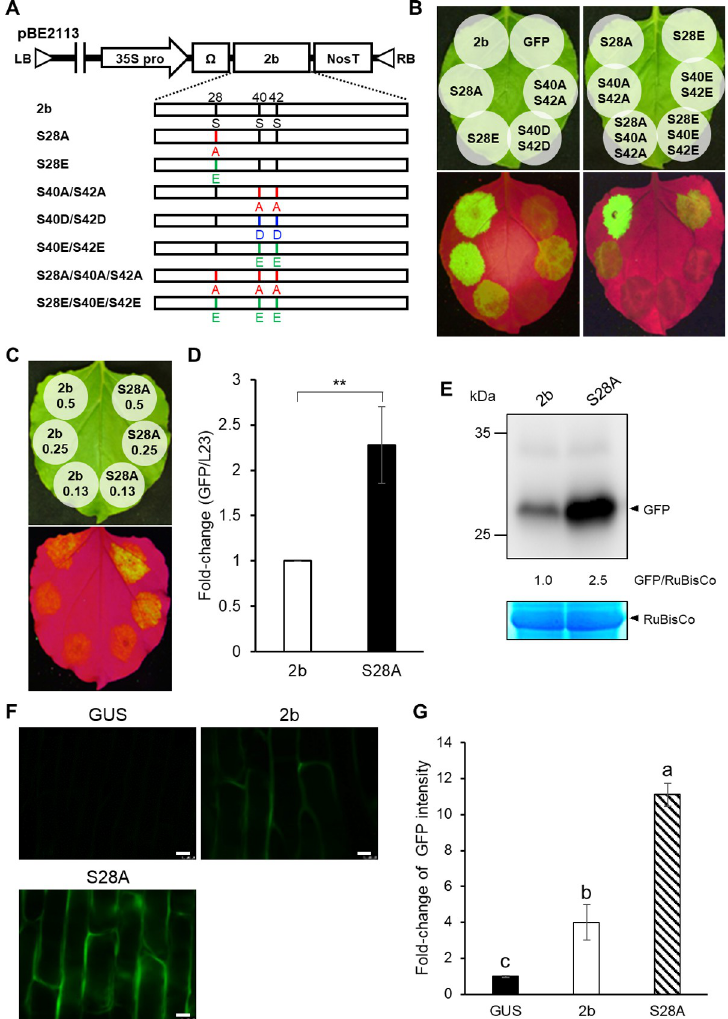
Fig 4. RSS activity of 2bs with mutations at phosphorylation sites. (A) Schematic structure of expression vector constructs containing mutant 2bs. The mutant 2bs were created by substituting S28, S40 and S42 with alanine (A), glutamic acid (E) or aspartic acid (D). (B) RSS activity of the mutant 2bs in the agroinfiltration transient expression assay. Agrobacterium cultures carried a 5:1:5 ratio of the GFP-sense (GFP), GFP-inverted-repeat (GFP-IR), and the 2b constructs. N . benthamiana leaves were agroinfiltrated with bacterial suspensions (~1.0 OD 600 ). GFP was examined at 2 days post-infiltration. Inoculum containing GFP and GFP-IR was used as a control for GFP silencing. (C–E) Comparison of RSS activity between 2b and S28A in N . benthamiana . The Agrobacterium suspension of 2b or S28A was serially diluted to OD 600 = 0.5, 0.25 and 0.13. The inocula were a mixture of Agrobacterium cultures carrying the GFP, GFP-IR and the 2b constructs. (C) Leaves were examined for GFP fluorescence at 2 days post-infiltration. (D) Real-time RT-PCR to compare GFP mRNA levels between 2b and S28A. The agroinfiltrated patches, where GFP, GFP-IR and 2b were simultaneously expressed, were excised. Mean values ( ± SE) are fold-changes when the value in 2b was set to 1.0. The values were analyzed on log-transformed data by Student’s t -test ( �� P < 0.01). (E) GFP in agroinfiltrated patches was detected by western blot analysis using anti-GFP antibodies. RuBisCo large subunit is shown as a loading control. The ratios of GFP/RuBisCo were densitometrically calculated when the value in 2b was set to 1.0. (F and G) Comparison of RSS activity between 2b and S28A in onion epidermal tissues. Onion bulb scales were infiltrated with a mixture of Agrobacterium suspension of GFP, GFP-IR and 2b. The plant experimental vector pBE2113 (GUS) was used as a negative control. GFP florescence was observed with an epifluorescence microscope. GFP fluorescence intensity was measured for three different onion scales using the LAS AF program (Leica). Scale bar: 50 μ m. The values of GFP florescence are fold-changes when the value in GUS was set to 1.0. Means ( ± SE) were tested on log-transformed data for a significant difference using Tukey’s multiple comparison test ( P < 0.05); different letters above the bars indicate a significant